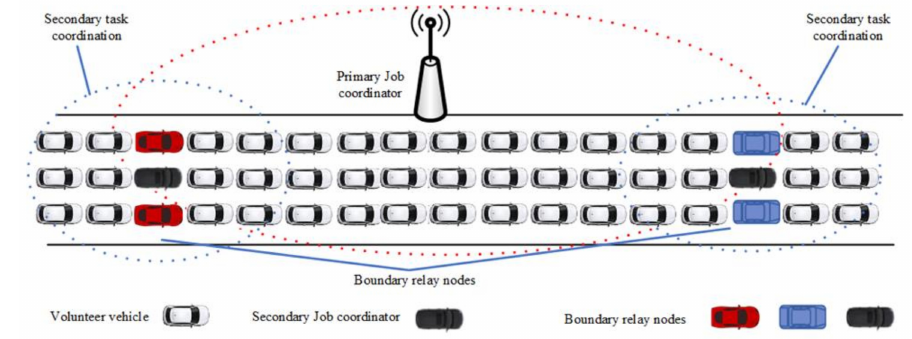
Figure 3. Boundary relay